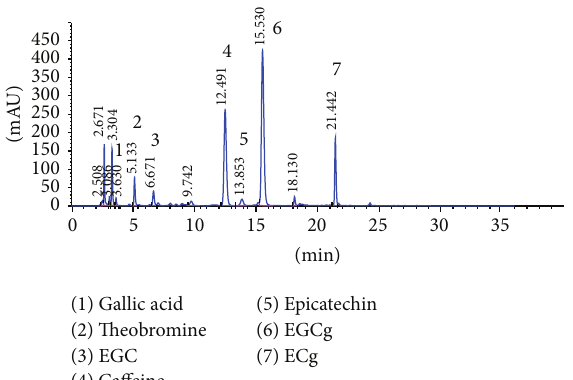
Figure 2: HPLC chromatogram of representative tea accession quantified using ISO: 14502-2